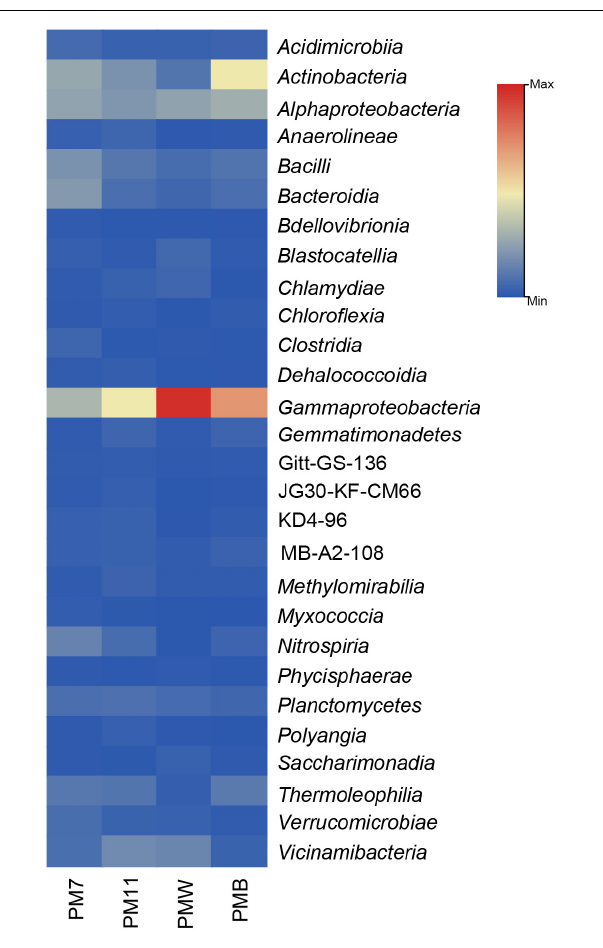
Firmicutes in PM7 and PMB (11% and 4%) and Acidobacteriota in PM11 and PMW (10 and 8%).